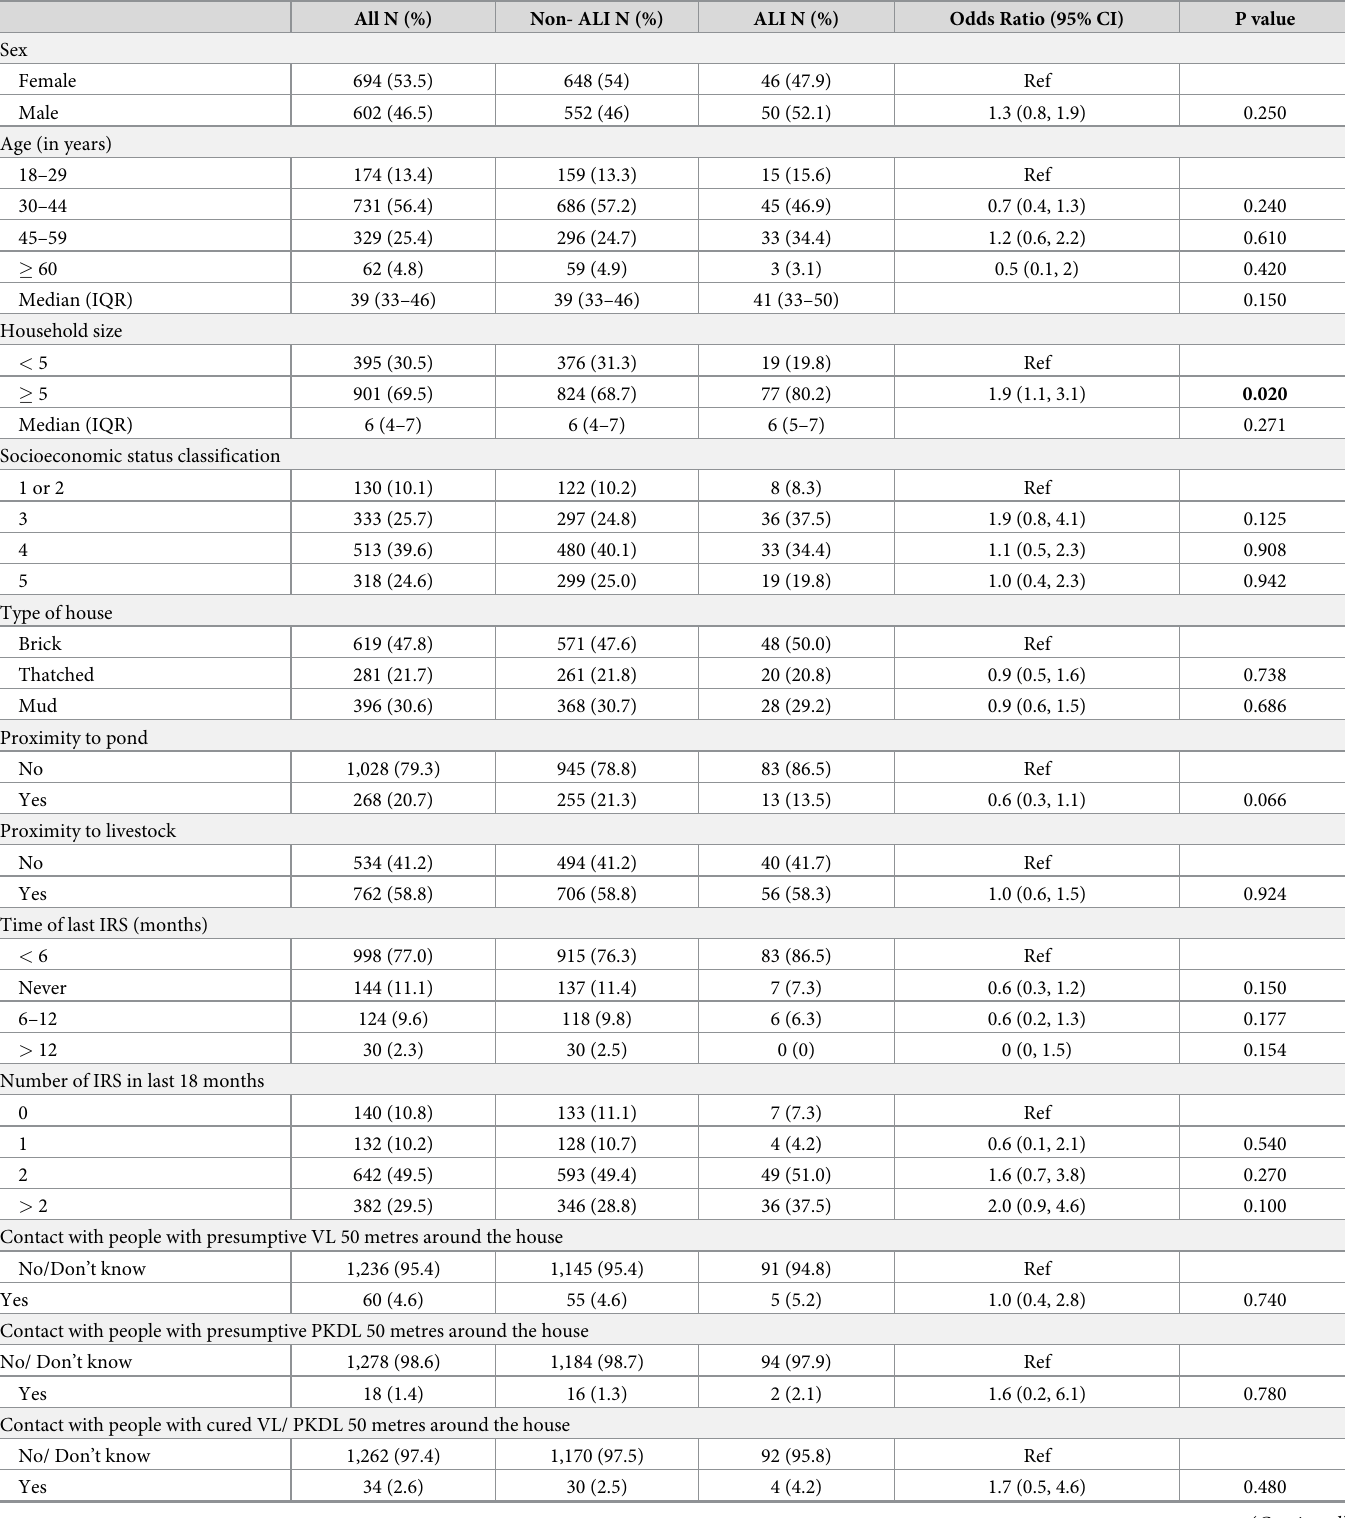
Table 3. Household-related risk factors for asymptomatic Leishmania infection (ALI) among 1,296 people living with HIV (PLHIV) in Bihar,